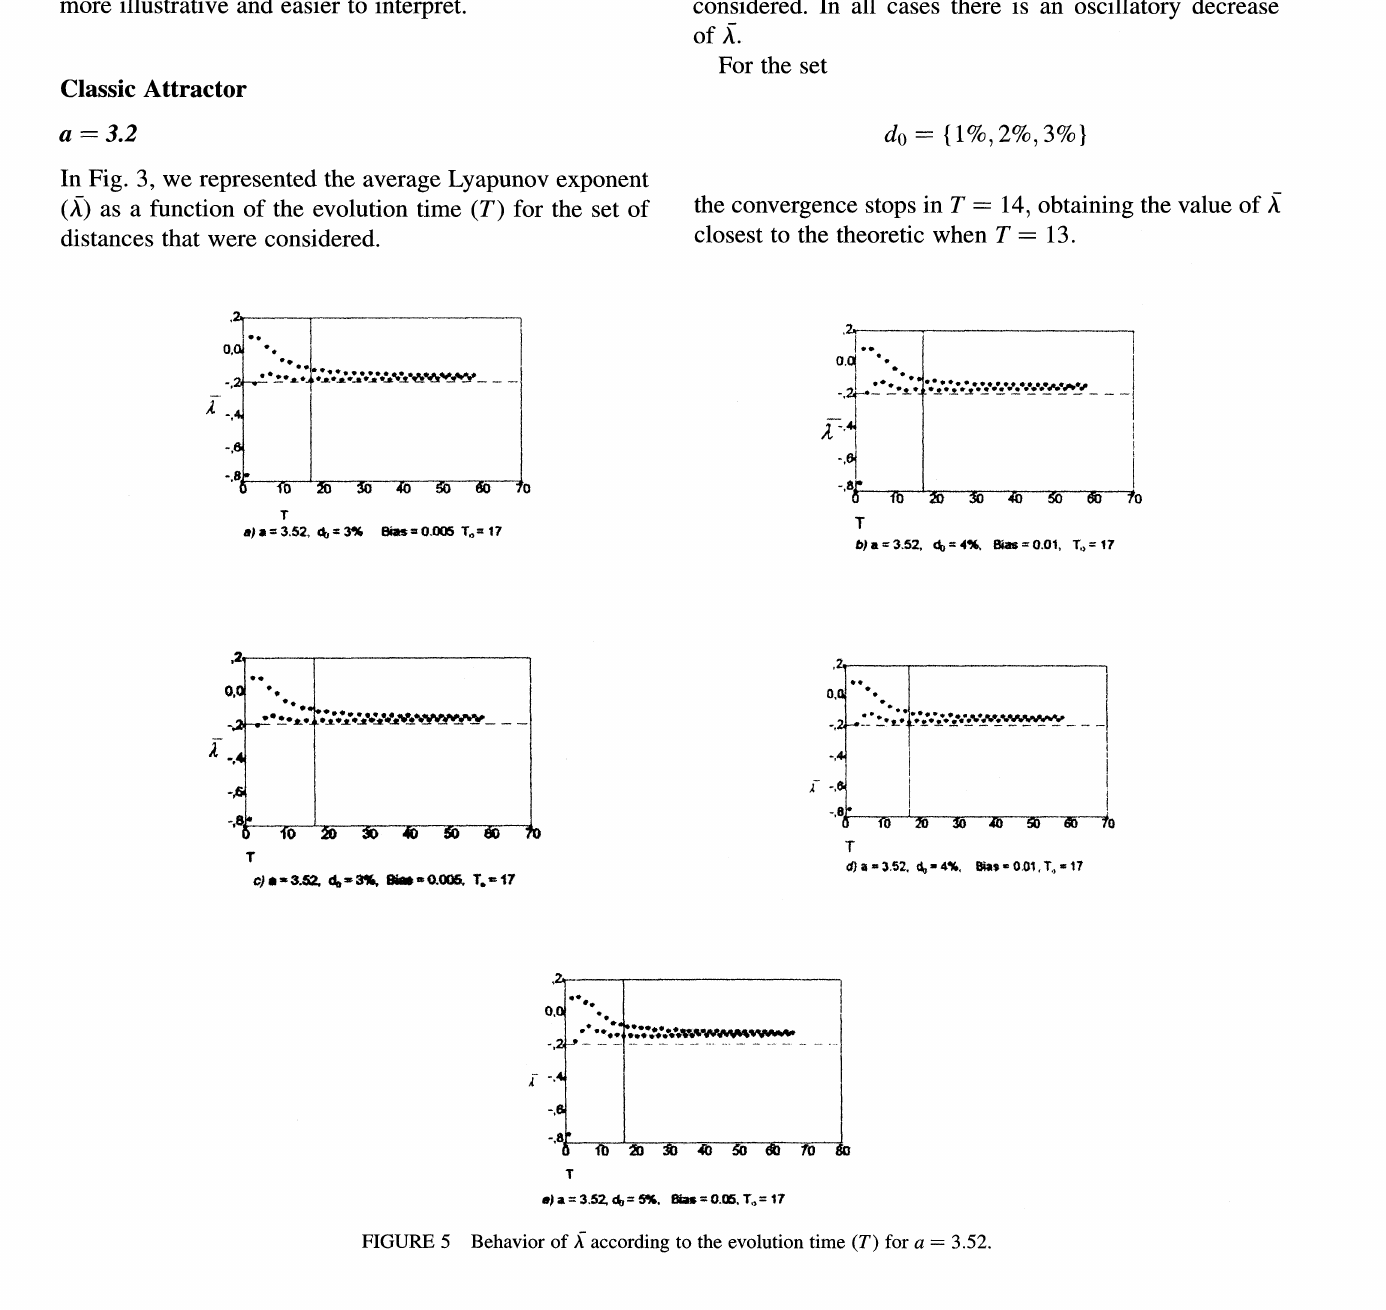
FIGURE 5 Behavior of X according to the evolution time (T) for